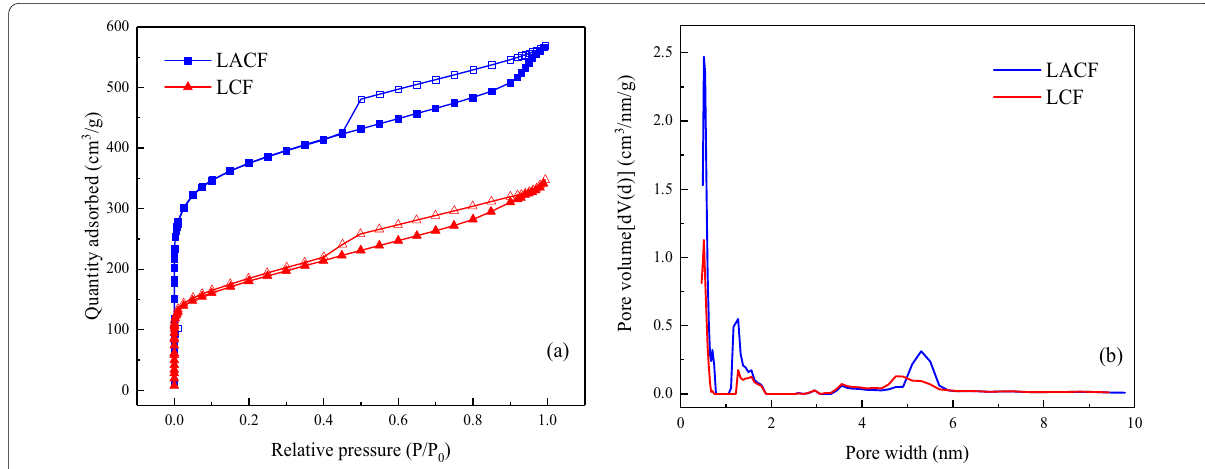
Fig. 14 a N 2 adsorption/desorption isotherms recorded at 77 K and b DFT pore size distribution of the LCF and LACF